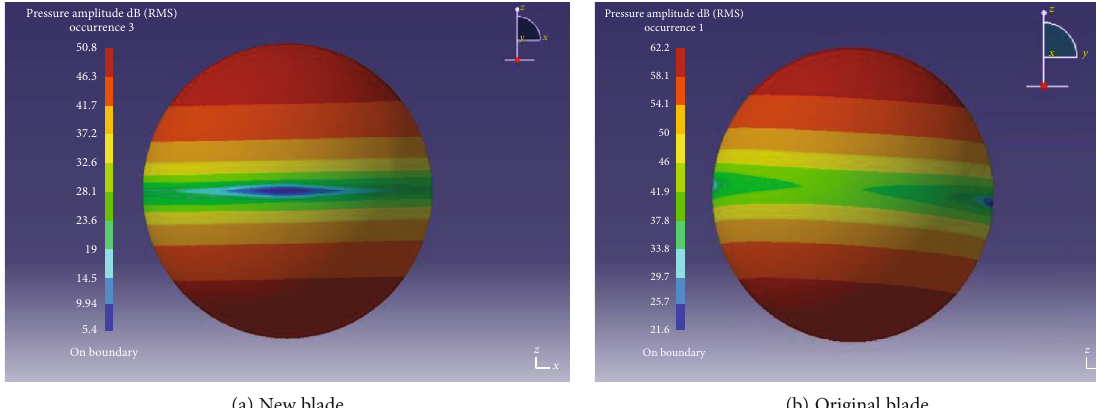
Figure 11: 1000 rpm spherical fi eld sound pressure cloud.